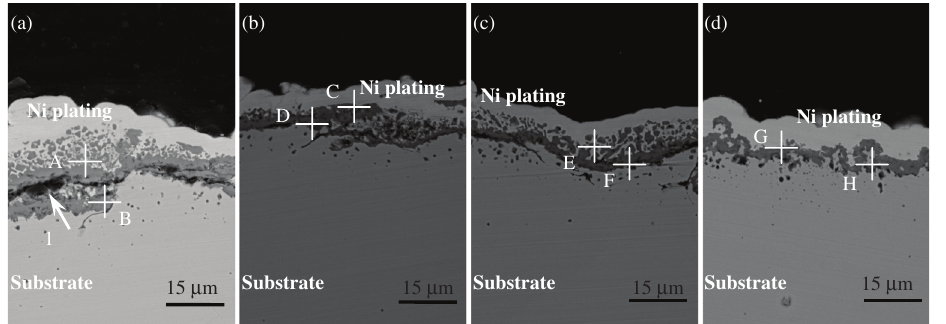
Figure 5: Cross-sectional morphologies of (a) stainless steel, (b) stainless steel with AlY coating, (c) stainless steel with AlY coating after pre-oxidation and (d) stainless steel with AlY coating after diffusion